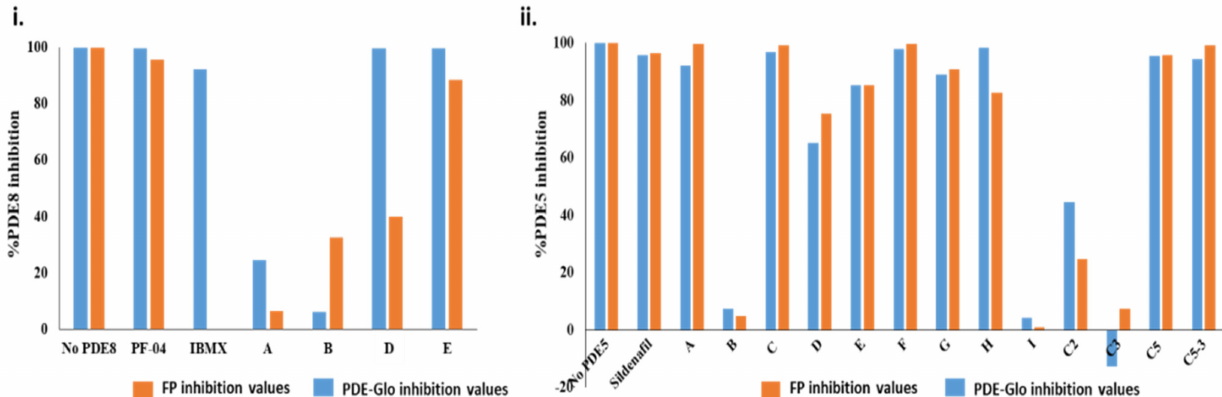
Figure 4. Comparison of PDE-Glo TM and FP assay results for PDE inhibition. The results for fluorescence polarization (orange) and luminescence-based PDE-Glo TM (blue) for PDE8 ( i ) and PDE5 ( ii ) are compared and depicted. No PDE8 or PDE5 was used as a negative control for maximal signal (100%); PF-04957325 (99.8%) and sildenafil (98.5%) inhibitors were used as positive controls for highest inhibition. PDE8 was incubated with extracts A, B, D, and E. Disparity is seen between the two assays for extracts A and B. ( ii ) Effect of extracts A–F, compounds G, H, and I, and fractions from extract C on PDE5 inhibition is compared for the two assays. Inhibition values for FP and PDE-Glo TM assays were calculated as described in methods, and the error bars were too small to be visible. The values are tabulated in Supplementary information Table